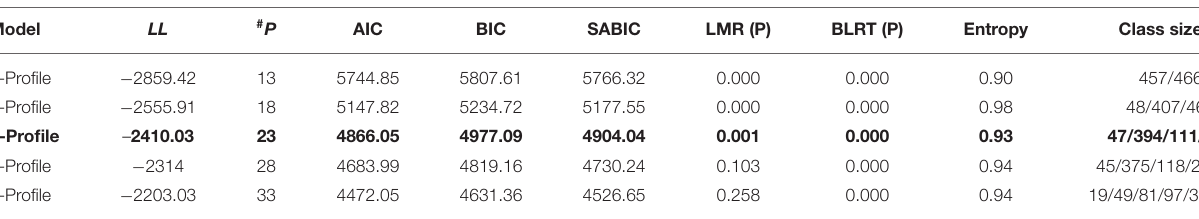
TABLE 2 | The model selection criteria of LPA. Model